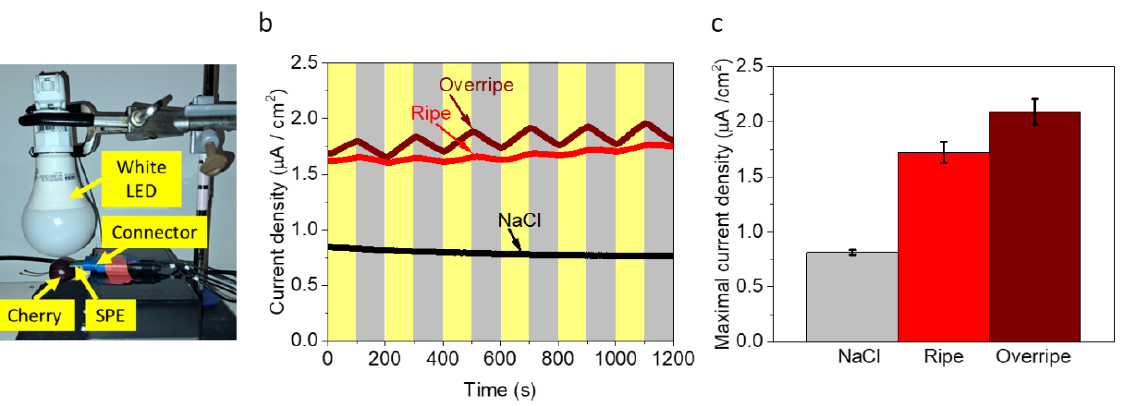
Figure 3. Direct photocurrent production from a Cherry. CA of a cherry and 0.1 M NaCl solution (control) was measured in dark/light intervals of 100 s applying a potential of 0.9 V on the anode. ( a ) Photograph of the experimental setup. An SPE was inserted into the center of the cherry (5 mm below its top). Illumination was conducted from the top using a white LED. Intensity at the SPE surface below the cherry was 1000 W/m 2 . The SPE was inserted into a connector for the potentiostat. Yellow labels with arrows indicate each system elements. ( b ) CA of 0.1 M NaCl (black), ripe (red) and overripe (wine) cherry under dark/light intervals of 100 s. Gray and yellow rectangular shapes represent the dark and light during the measurement, respectively. ( c ) Maximal current density of NaCl (gray), ripe cherry (red), and overripe (wine). Error bars represent the standard deviation over three independent